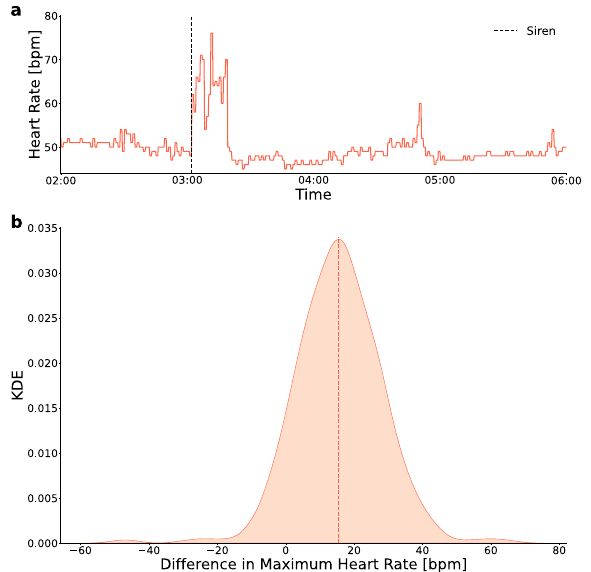
Fig. 1 Changes in heart rate following a siren. a An example of the change in heart rate for a single participant following a siren. The x-axis represents the time and the y-axis is the heart rate of the participant in beats per minute. Dashed, black, vertical line — the time period in which the siren was heard. b Distribution of the changes in heart rate following a siren compared with the baseline value over all participants. Since each participant could experience several sirens, each participant is represented by the mean of his/her changes. The x-axis represents the mean change in heart rate value and the y-axis is the kernel density estimator (KDE). Dashed, orange, vertical line — median value of the